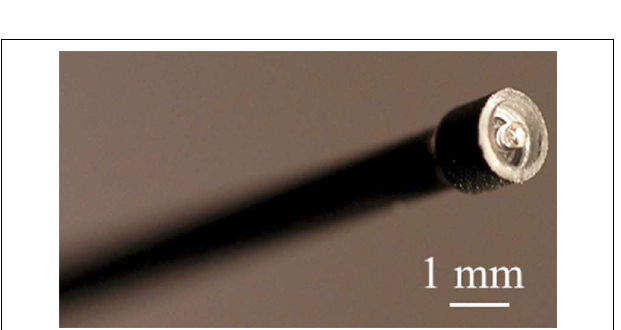
FIGURE 12 | Sapphire endtip mounted onto the NCF designed for 2.94 µ m guidance [ 51].